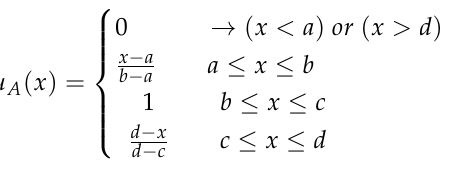
Figure A1. Trapezoidal membership function.